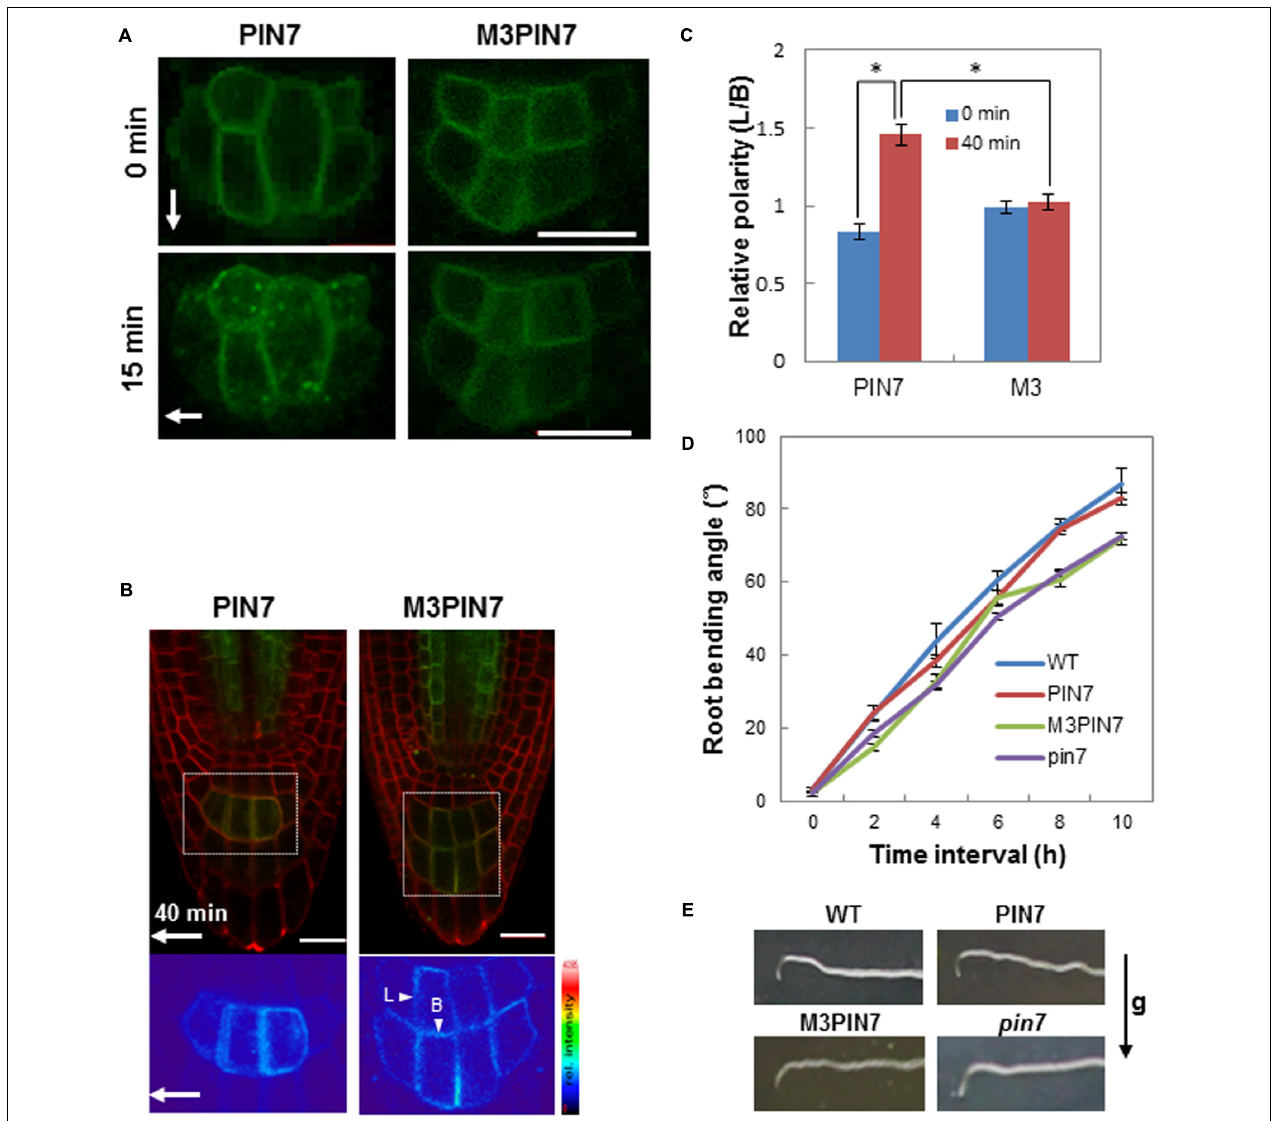
FIGURE 5 | Effect of M3 mutation on PIN7 trafficking and root gravitropism. (A) Representative confocal fluorescence images of PIN7 ( ProPIN7:PIN7:GFP ) and M3PIN7 (M3, ProPIN7:M3PIN7:GFP ) in root columella cells. Images were taken before (0 min) or after 90 ◦ -gravity stimulation for 15 min. Arrows indicate the gravity direction Bar = 20 µ m. (B) Fluorescence images of PIN7 and M3PIN7 in root columella regions after 40-min gravity stimulation. Arrow indicates the gravity direction. Red signals were from FM4-64 staining. Bar = 20 µ m. (C) The lateral/basal (L/B as indicated in B ) ratio of PIN7 or M3PIN7 fluorescence intensity in columella cells at 0 min and after 40 min gravity stimulation. Data represent means ± SE ( n = 12 cells from 6 roots for each construct). Asterisks indicate that differences are significant ( P < 0.0001) in t -test. The difference of M3 values between 0 and 40 min was not significant ( P = 0.631). (D) Kinetics of root gravitropism of WT, homozygous pin7 , complemented with PIN7 (PIN7) and M3 (M3PIN7), and homozygous pin7 . Data represent means ± SE ( n = 29–40 roots). (E) Representative root images of the plants described in (D) after a 10-h gravity stimulus. The arrow indicates the gravity (g)